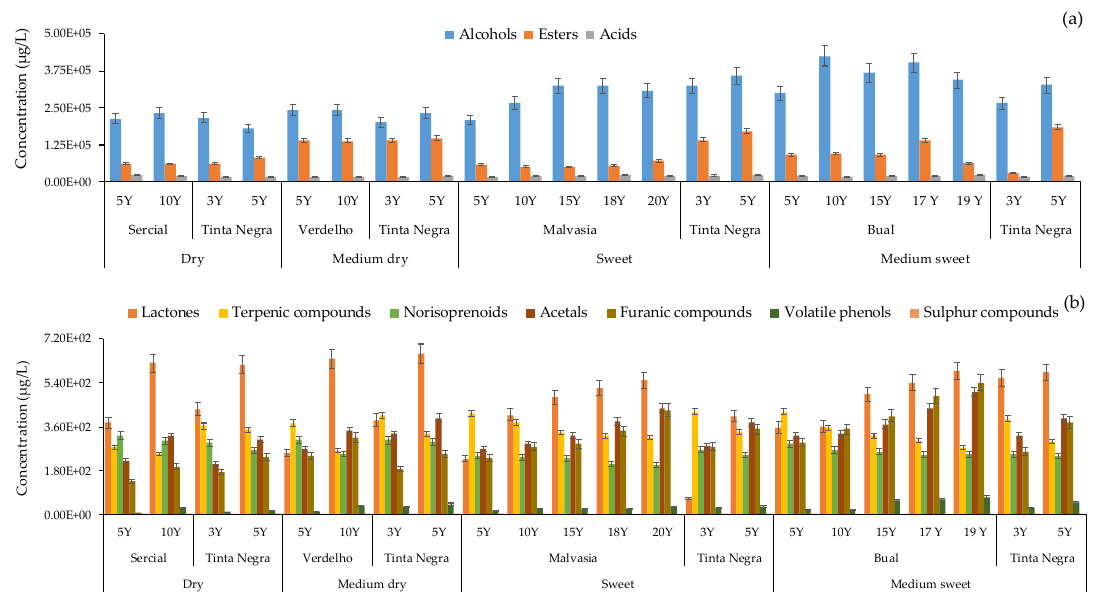
Figure 3. Total relative concentration ( µ g / L) of major ( a ) and minor ( b ) chemical families identified in Madeira wine.